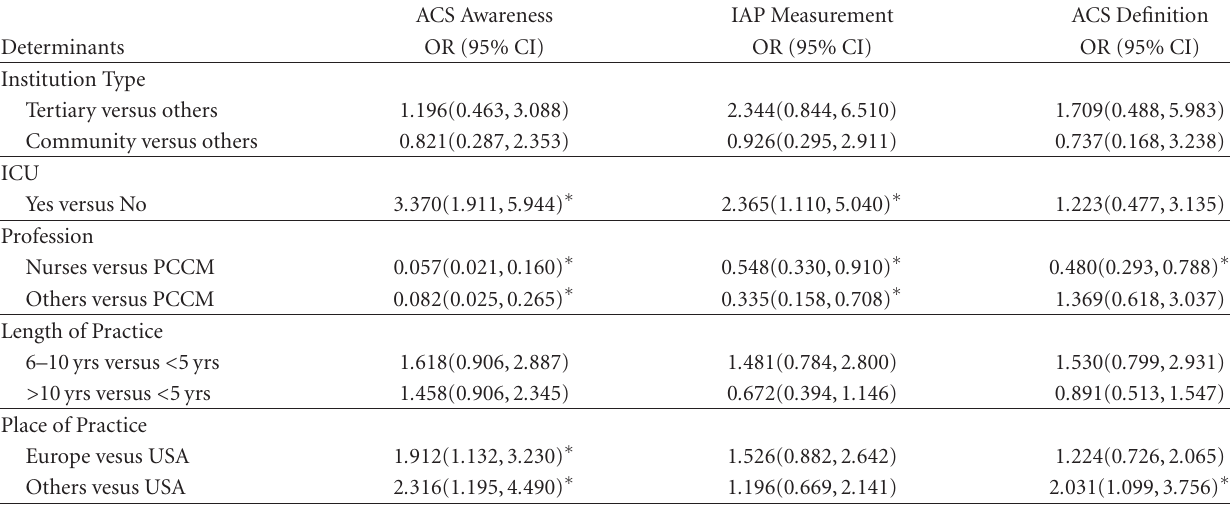
Table 2: Univariable analysis of factors a ff ecting ACS awareness, IAP measurement, and knowledge of ACS